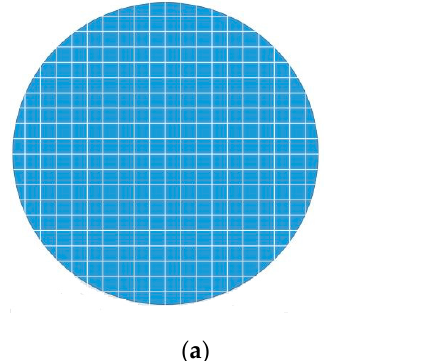
Table 3. Summary of governing equations.